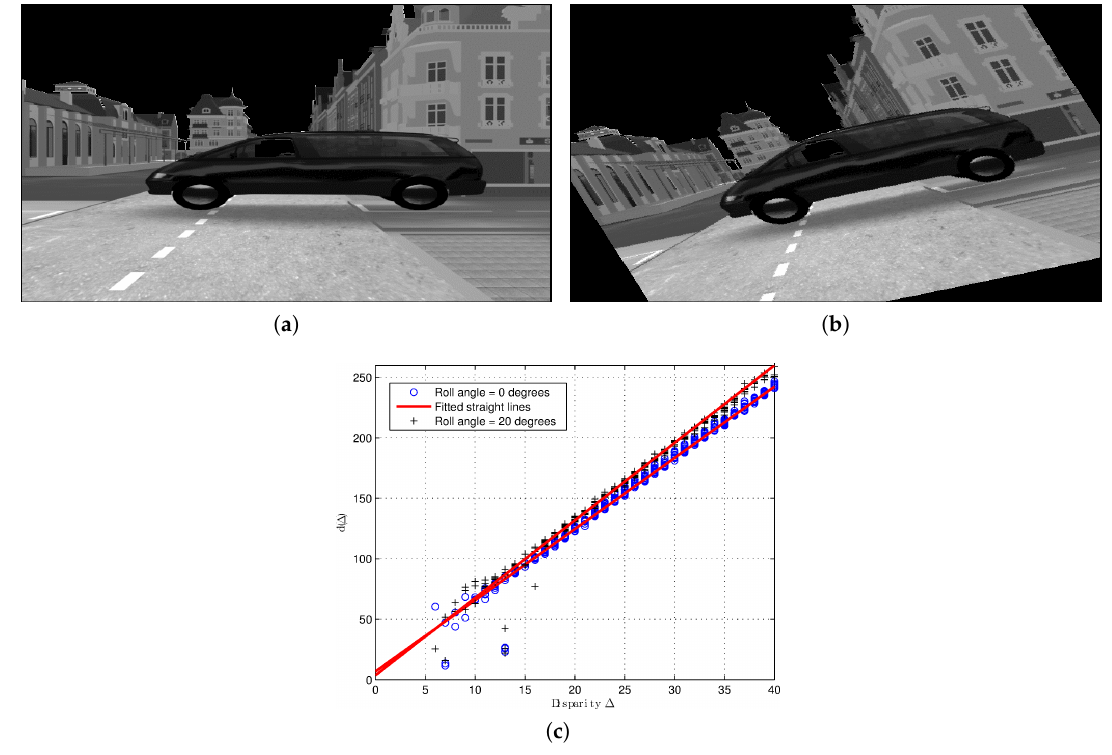
Figure 8. Example of the partial results of the self-calibration Method 2 for two different values of roll angle. ( a ) Visible image of a synthetic traffic scenario [10] in an urban environment with a value of roll angle equal to 0 ◦ ; ( b ) visible image of a synthetic traffic scenario in an urban environment with a value of roll angle equal to 20 ◦ ; ( c ) point clouds obtained from each value of roll angle with their respective straight